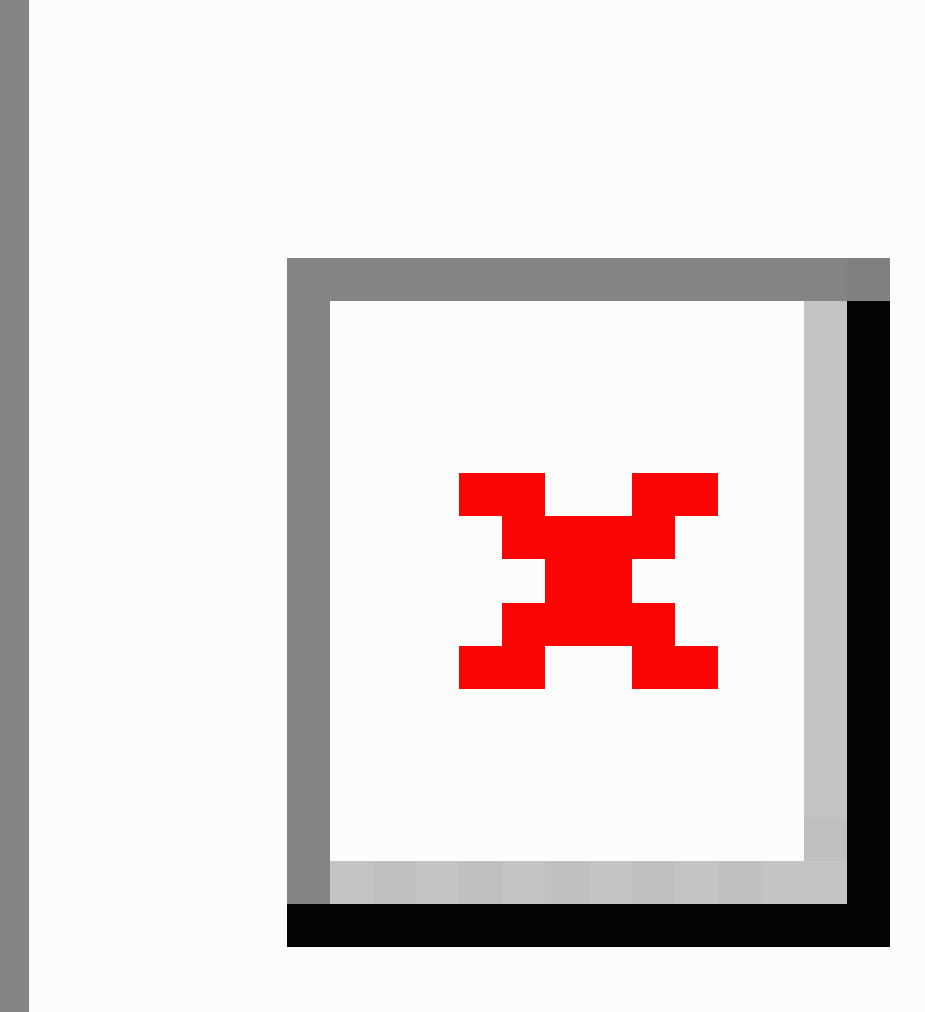
Figure 3. MindfuLiving lesson